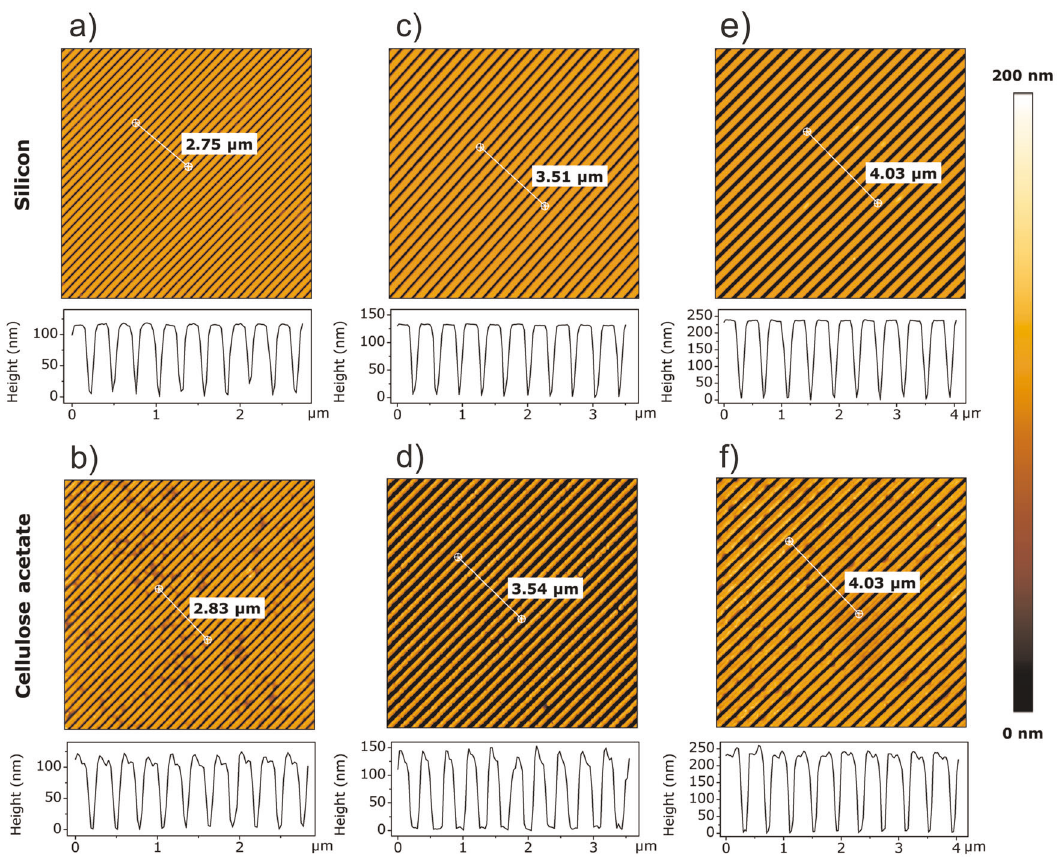
Fig. 2 AFM topography images and pro fi les along the lines indicated in the images of grating structures fabricated in Si and in CdA fi lms, with SP ( a , b ), MP ( c , d ), and LP ( e , f )